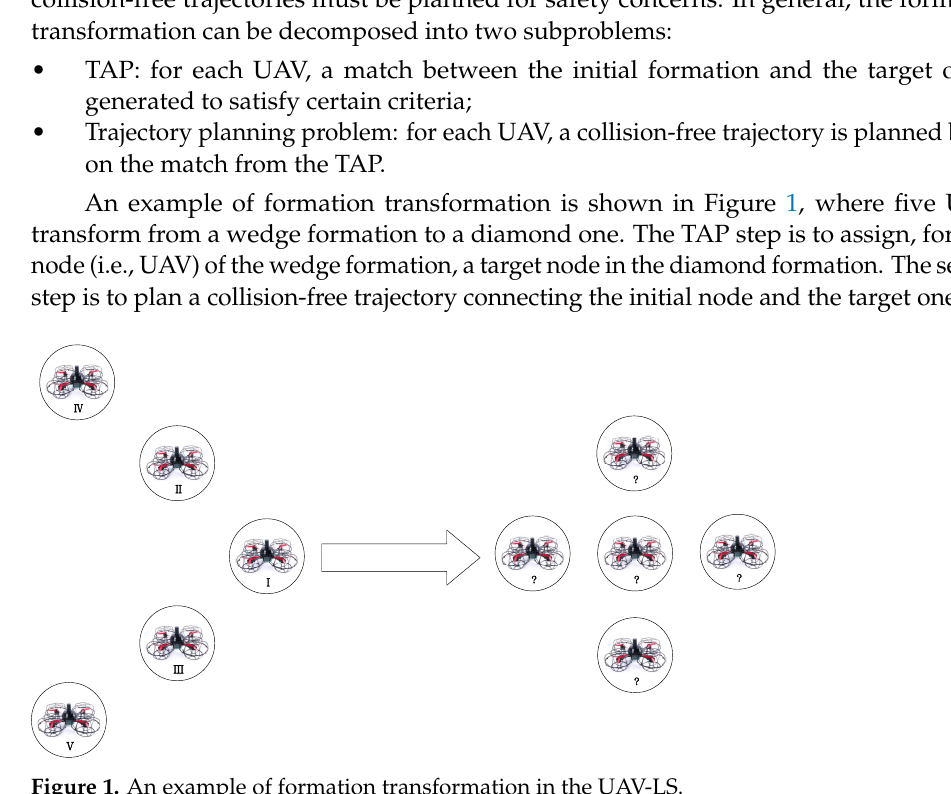
Figure 1. An example of formation transformation in the